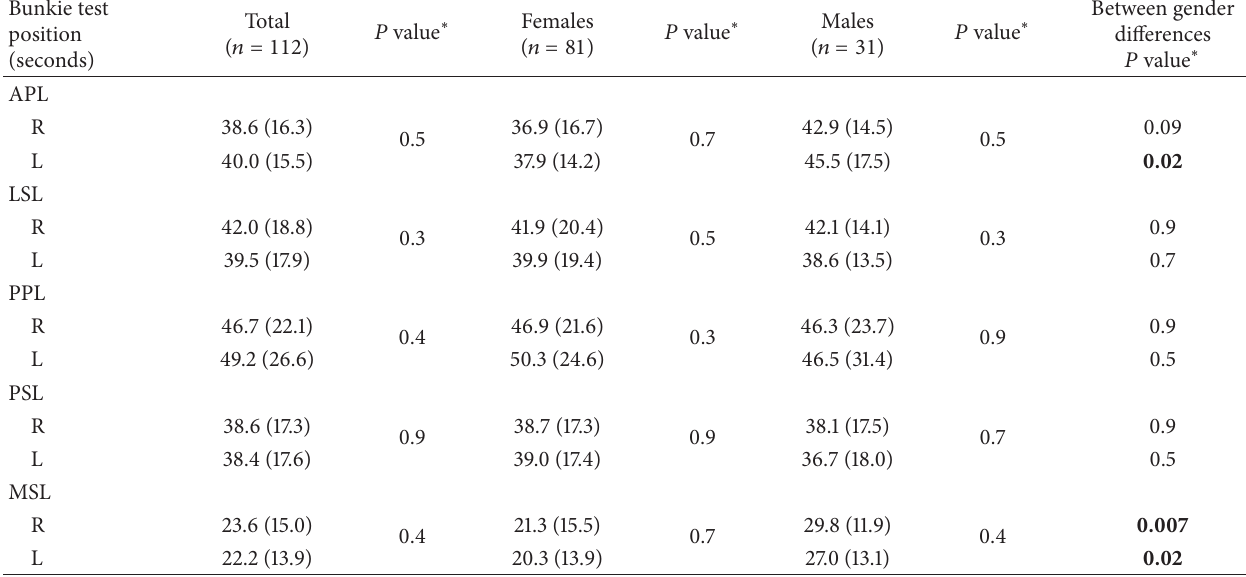
Table 2: Bunkie test scores (mean ± SD) and comparisons between female and male